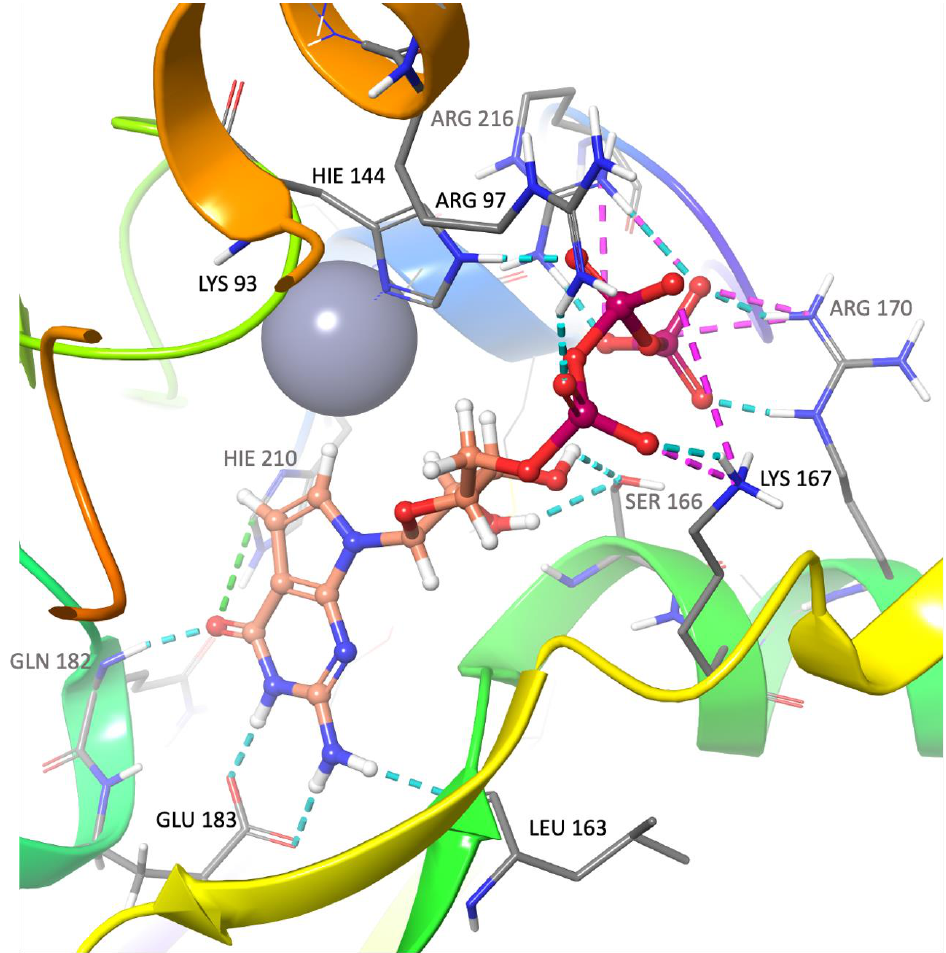
Figure 2. 7-Deaza-GTP docked in the GTPCH1-binding pocket ( − 14.94 kcal/mol). All bonds are depicted as dotted lines: hydrogen bond—blue; salt bridges—pink; aromatic H-bond—green; pi–pi stacking—orange; pi-cation—red. Binding residues are annotated, and the zinc ion is depicted as a grey sphere. Table 1. Docking scores of identified hit compounds screened against the GCH1 active site.